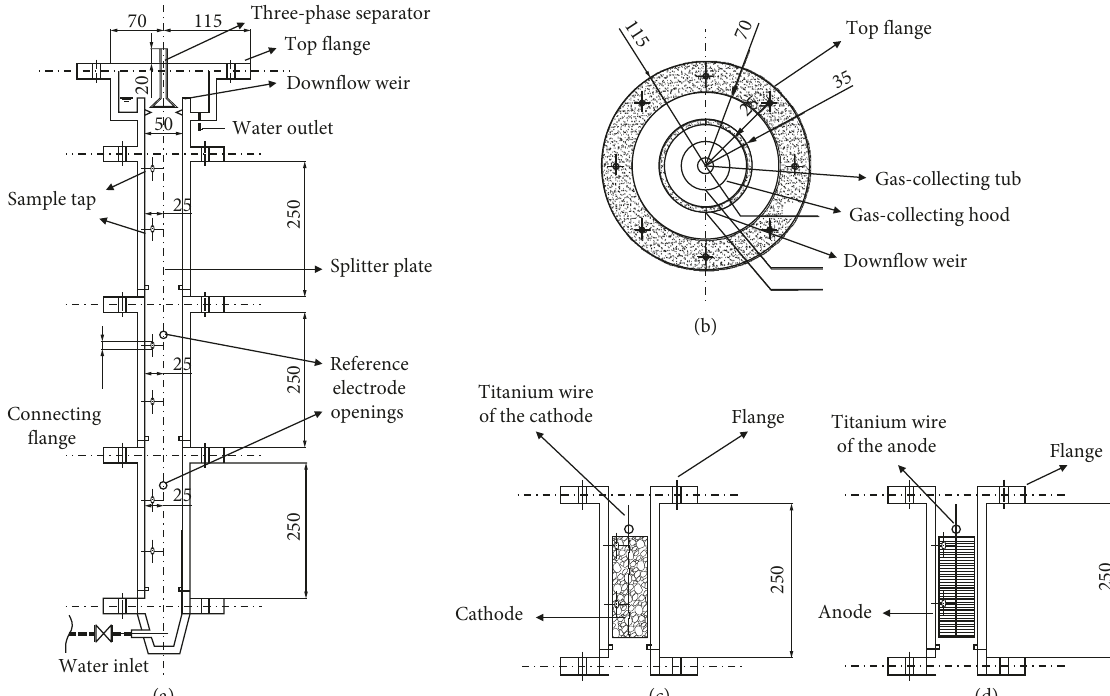
Figure 1: Three-electrode (cathode-anode-cathode) upflow bioelectrochemical deoxygenation reactor: (a) the reactor design; (b) the top outlet weir design; (c) the cathode design; (d) the anode design. Table 1: Formula of inlet water for reactor start-up. Substance Vitamin